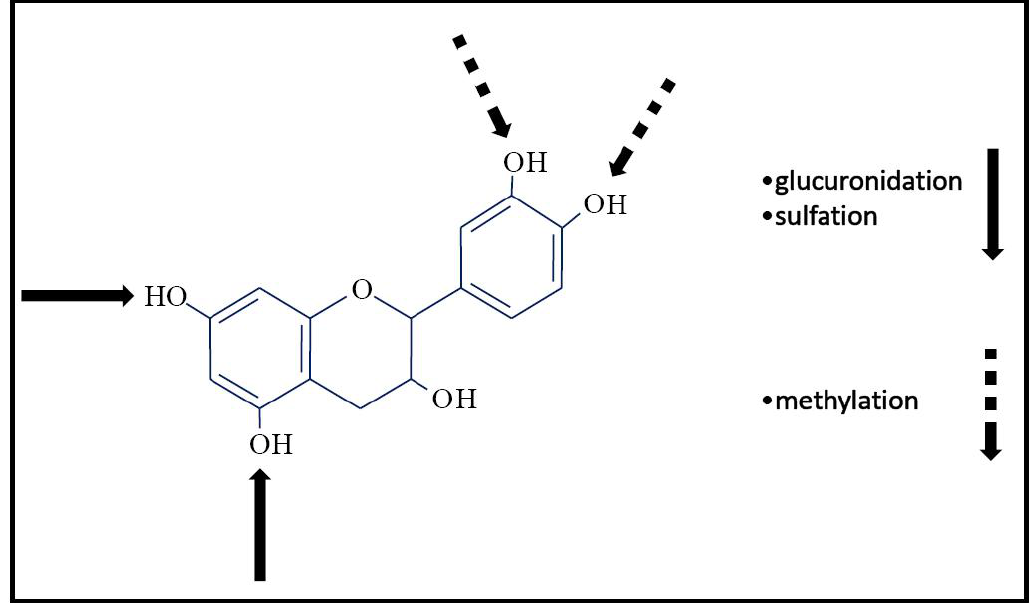
Figure 1. The potential sites of the conjugation process of the polyphenols are schematically illustrated. The broken arrows represent the potential methylation sites; the full arrows represent the potential glucuronidation and sulfation